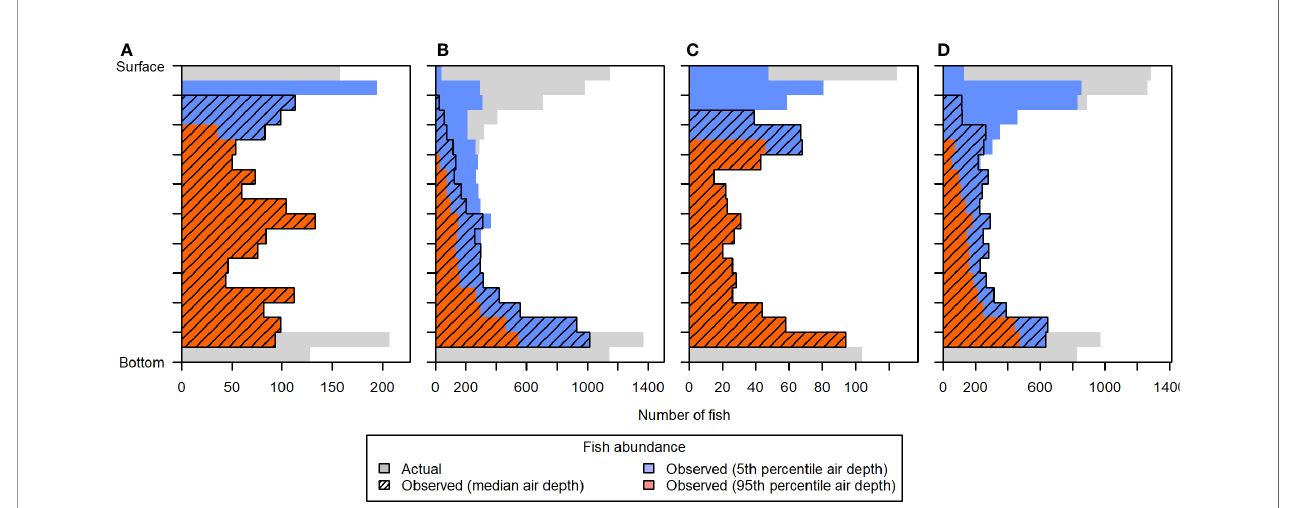
FIGURE 12 | Vertical distribution of fi sh in simulated distribution Scenario 5, during (A) low, (B) fl ood, (C) high, and (D) ebb tide. The “ actual ” vertical distribution (light gray) is overlaid by the vertical distributions that would be observed under different levels of contamination by entrained air: 5 th percentile air depth (blue), 50 th percentile air depth (hatched), and 95 th percentile air depth (dark orange). Each depth bin spans 5% of the total water column depth, to facilitate comparison across tidal changes in water level. Fish counts in the lowermost two depth bins were primarily reduced due to the height of the acoustic near fi eld above the sea fl